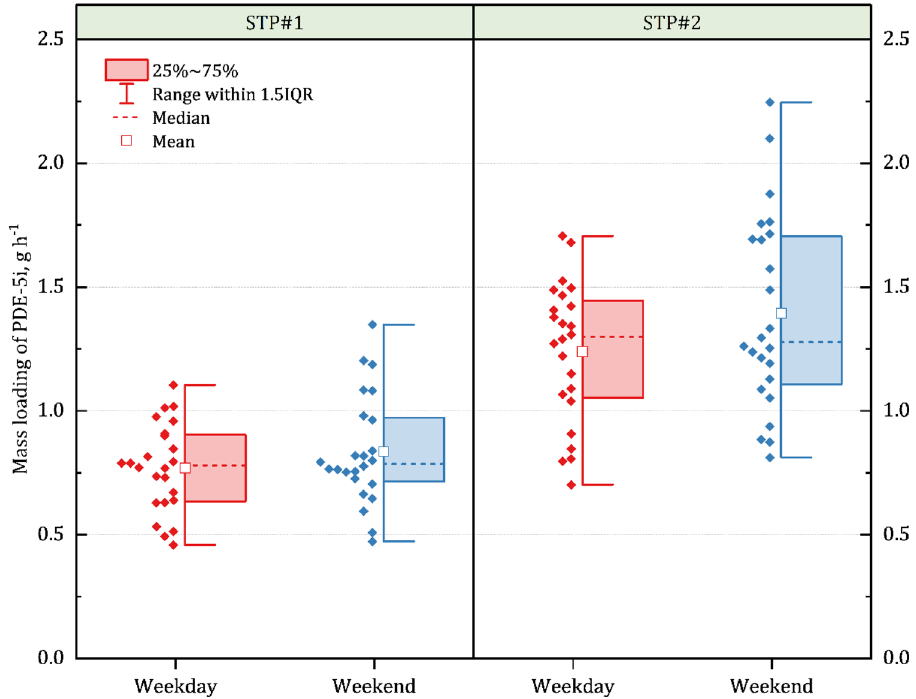
Figure 3. Boxplots for PDE-5i mass loadings on STP#1 and STP#2 calculated for weekday and weekend. Since no datum point was off the range for each STP set by 1.5 × IQR (inter-quartile range) and both mean and median are located within IQRs, the PDE-5i data are considered as normally distributed. For both weekday and weekend, PDE-5i mass loadings on STP#2 are higher than those on STP#1.